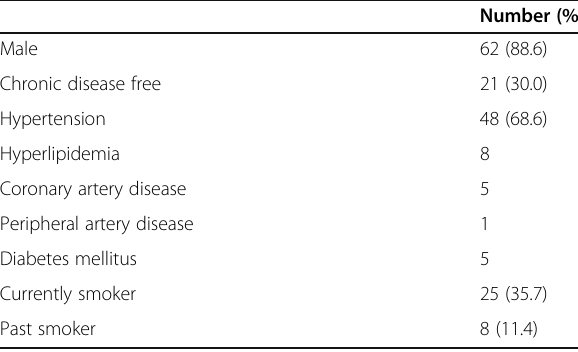
Table 2 The study population with their demographic